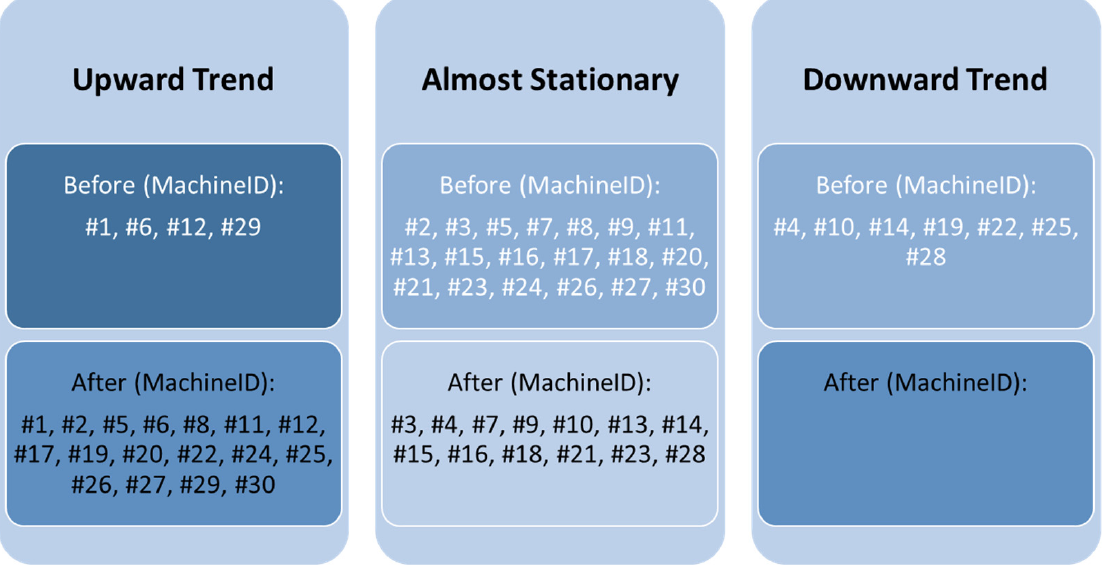
Figure 5. The relationship between idle time and time before and after the removal of outliers.